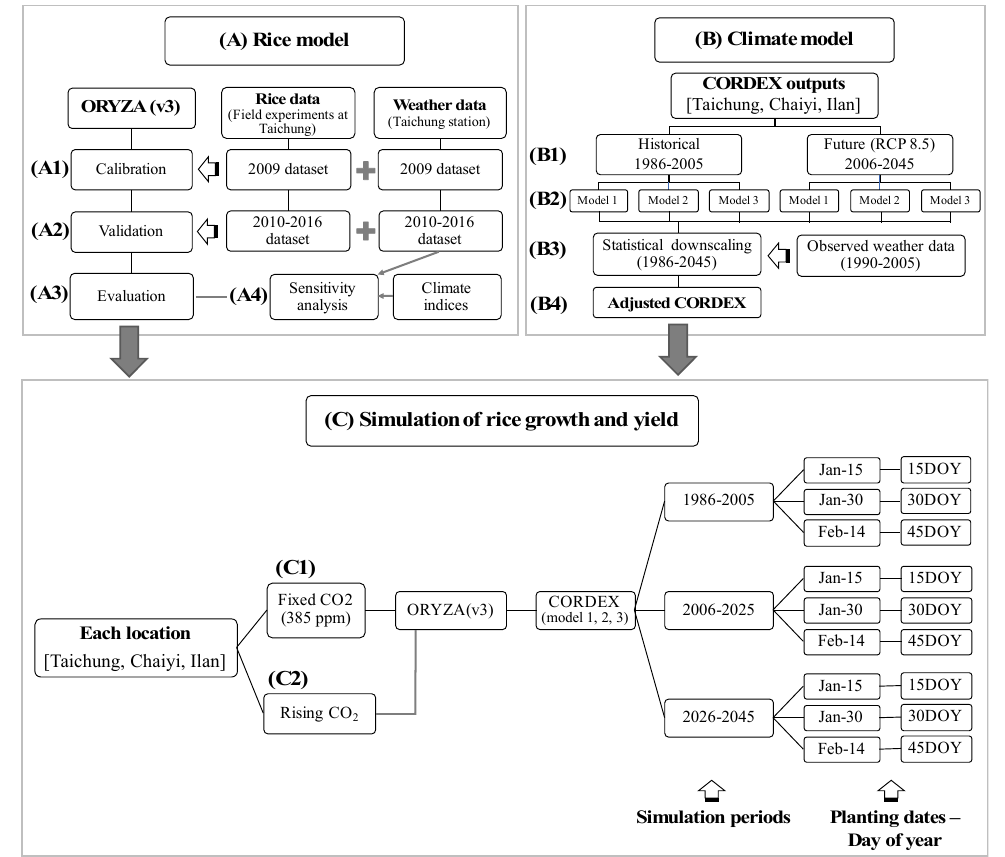
Figure 2. Diagrams of methodological approaches to simulate rice growth and yield by using ORYZA(v3) rice model and outputs from CORDEX. Step A describes datasets and computational process in ORYZA (v3) for (A1) model calibration, (A2) model validation, (A3) model evaluation, and (A4) sensitivity analysis. Step B describes datasets and downscaling process of outputs from climate model: (B1) historical (1986–2005) and future (2006–2045) datasets, (B2) CORDEX models used in this study, (B3) downscaling process, and (B4) adjusted CORDEX dataset. Step C describes the components of rice growth and yield simulation for two scenarios of CO 2 input: (C1) fixed CO 2 at 385 ppm and (C2) rising CO 2 concentration.